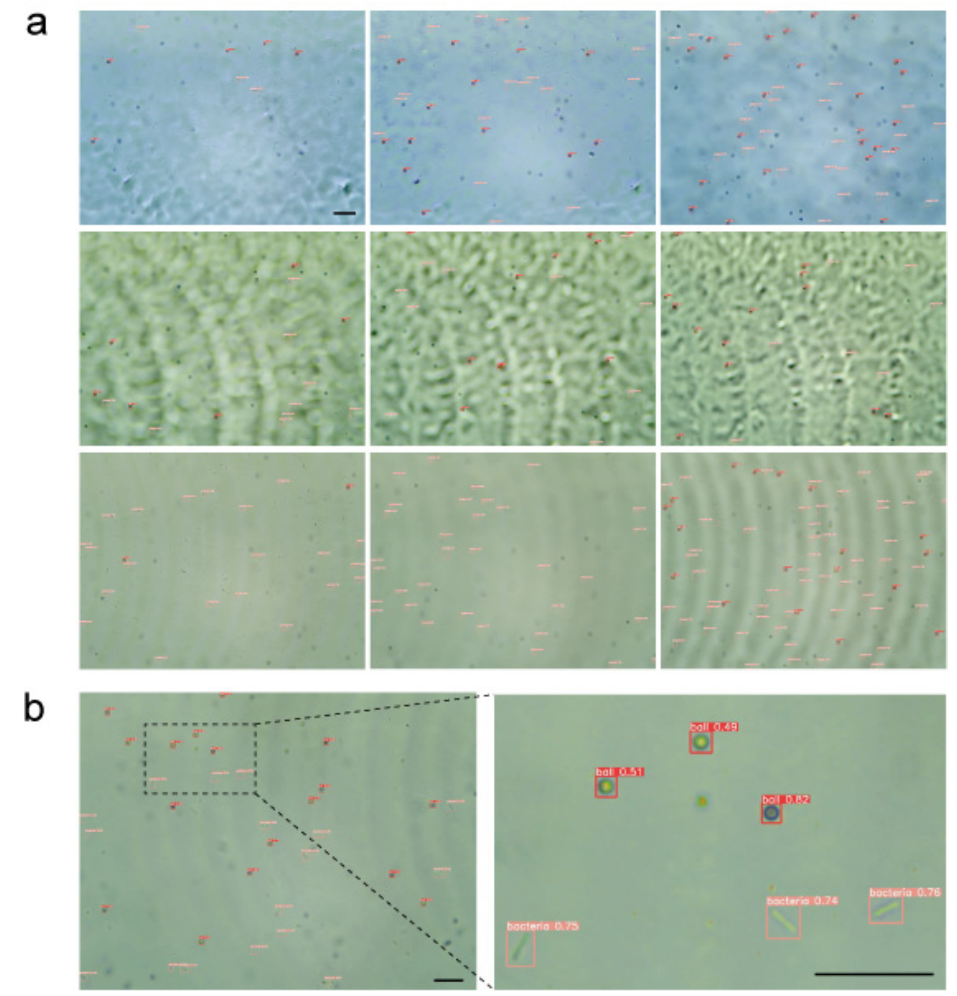
Figure 4. Recognition effect: ( a ) The recognition effect under different backgrounds and in low, medium, and high concentrations of bacteria liquid, respectively; (b ) Enlarged picture of recognition effect under normal background. The scale bars represent 20 μ m.